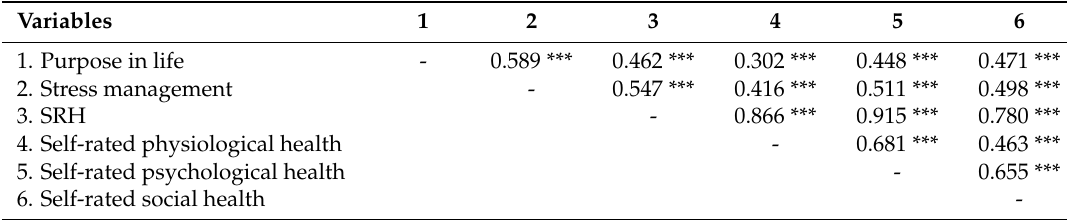
Table 2. Pearson’s correlation analysis between purpose in life, stress management, SRH and dimensions of